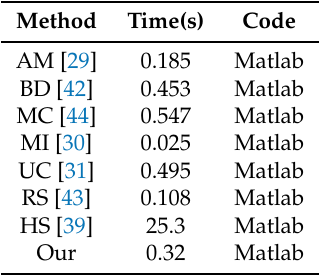
Table 2. The comparison of our model with seven state-of-the-art techniques for average running time (seconds per